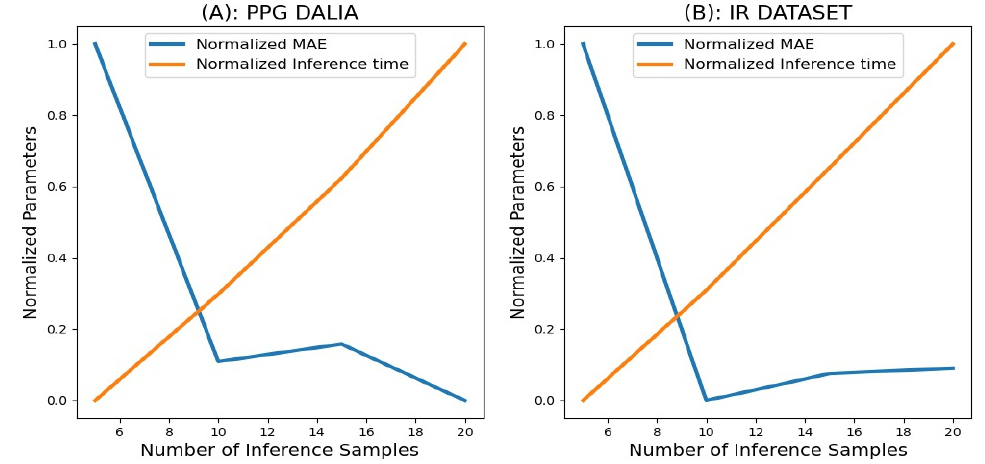
Figure 6. Number of inference sample vs, error and time. ( A ): Plot for PPG-DaLiA dataset; ( B ): plot for IR